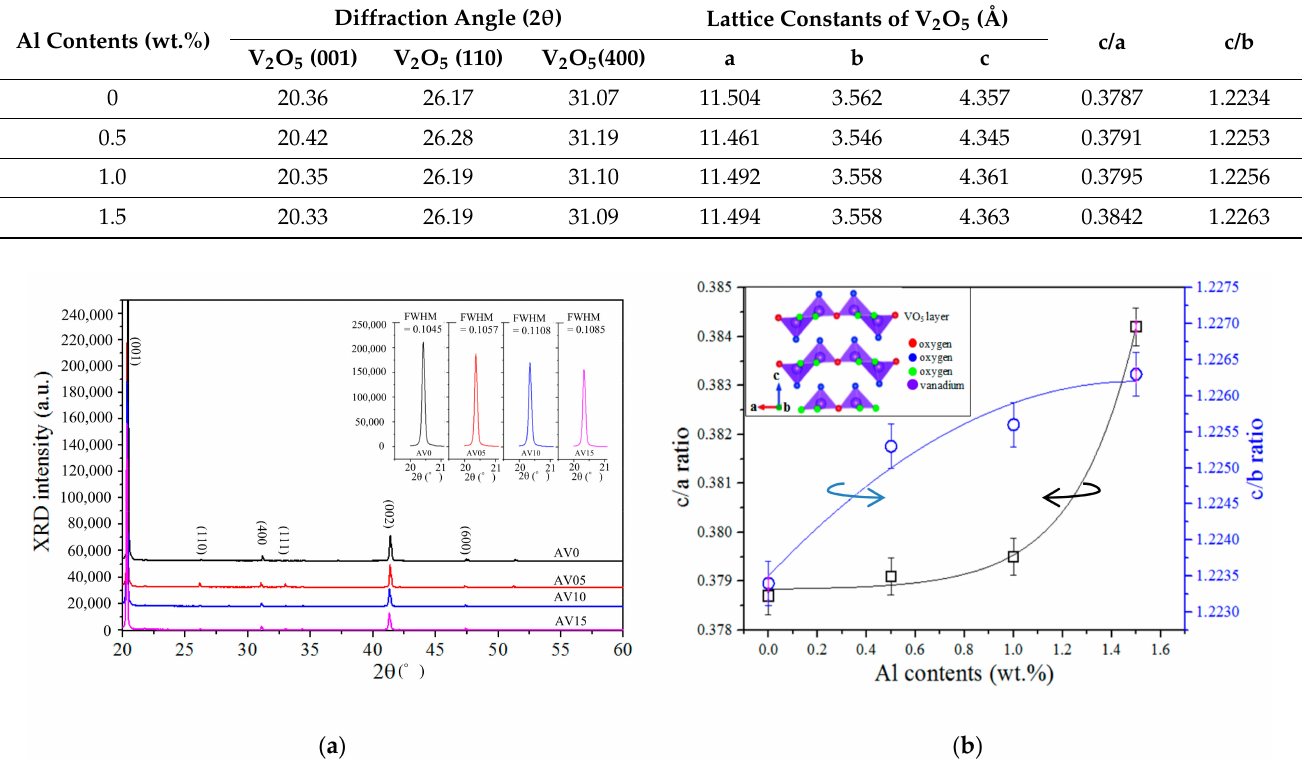
Figure 2. ( a ) Powder X-ray diffraction (XRD) analysis of AV NSs and the inset showing FWHMs varying Al dopants in V 2 O 5 (001); ( b ) c/a and c/b ratios varying with Al dopant (wt.%); the inset depicting the V 2 O 5 molecular structures